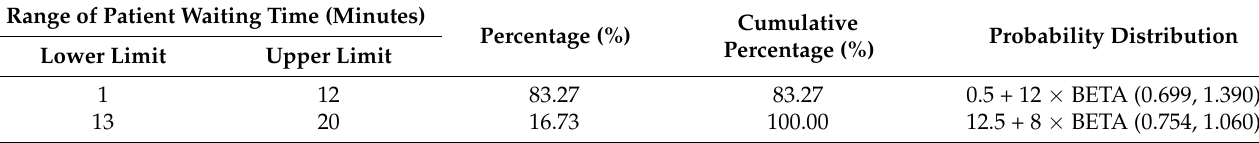
Table 2. F3 distribution for late outpatients.